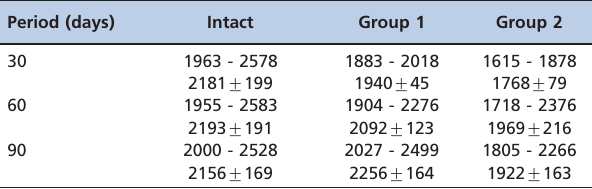
Table 1 - Transverse ultrasound velocity (m/s) for the intact and operated tibiae according to group and period (range, average and